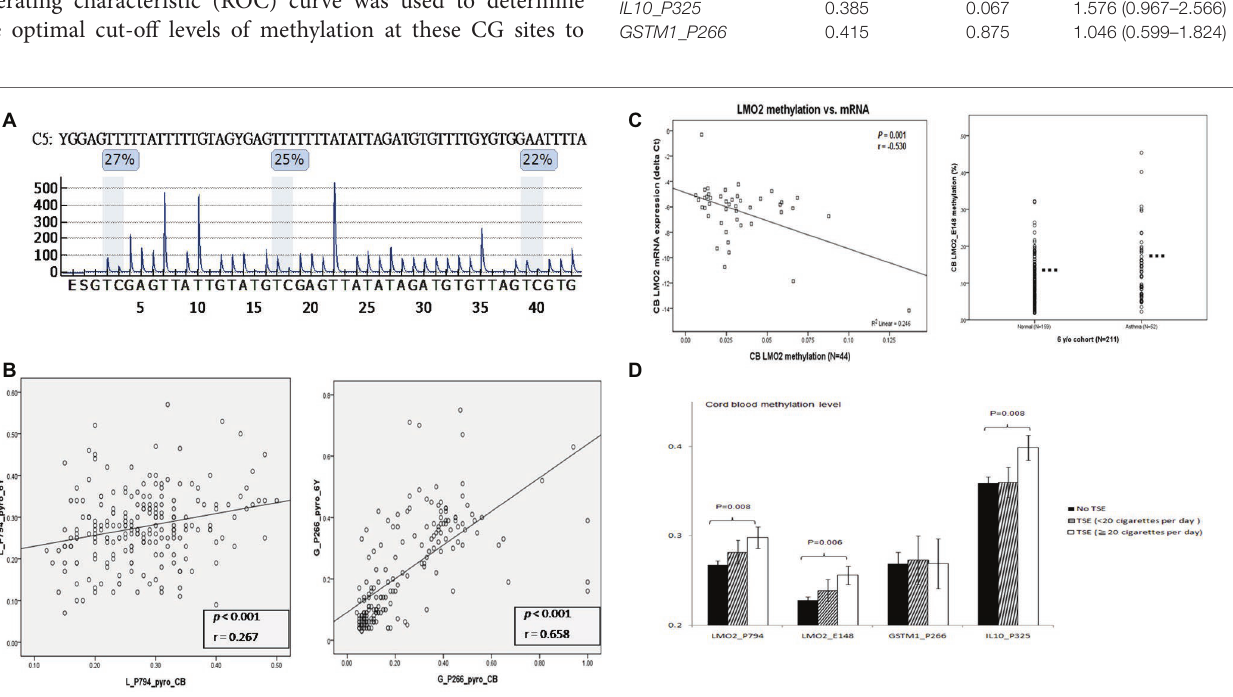
FIGURE 2 | Quantitative and functional validation of LMO2 methylation contents in different methods, ages, mRNA expression, and childhood asthma. (A) Quantification of CG methylation by pyrosequencing. The difference of methylated and unmethylated LMO2 promoter CG sites across the P794 region was located between 22 and 27%. (B) The LMO2_P794 CG methylations levels in the newborn stage (X-axis) revealed a significant correlation to those at 6 years of age (Y-axis) ( r = 0.267, p < 0.001), and GSTM1_P266 CG methylation levels at the newborn stage were highly significantly correlated with those at 6 years of age ( r = 0.658, p < 0.001). The statistics is analyzed by Pearson coefficiency. (C) Functional association of LMO2 CG methylation contents with mRNA expression and childhood asthma. The higher the CG methylation contents the lower mRNA expression (left panel). The statistics is analyzed by Pearson coefficiency. In the student t test, children with asthma had a significantly higher CG contents than those without asthma (right panel). (D) LMO2_P794, LMO2_E148, and IL10_P325, but not GSTM1_P266 CG sites revealed significantly higher CG methylation contents in those with a heavy prenatal exposure of PTS ≥ 20 cigarettes/day (black: no smoke; slash: <20 cigarettes/day; white: ≥20 cigarettes/day). The statistics is analyzed by one-way ANOVA and post-hoc test.